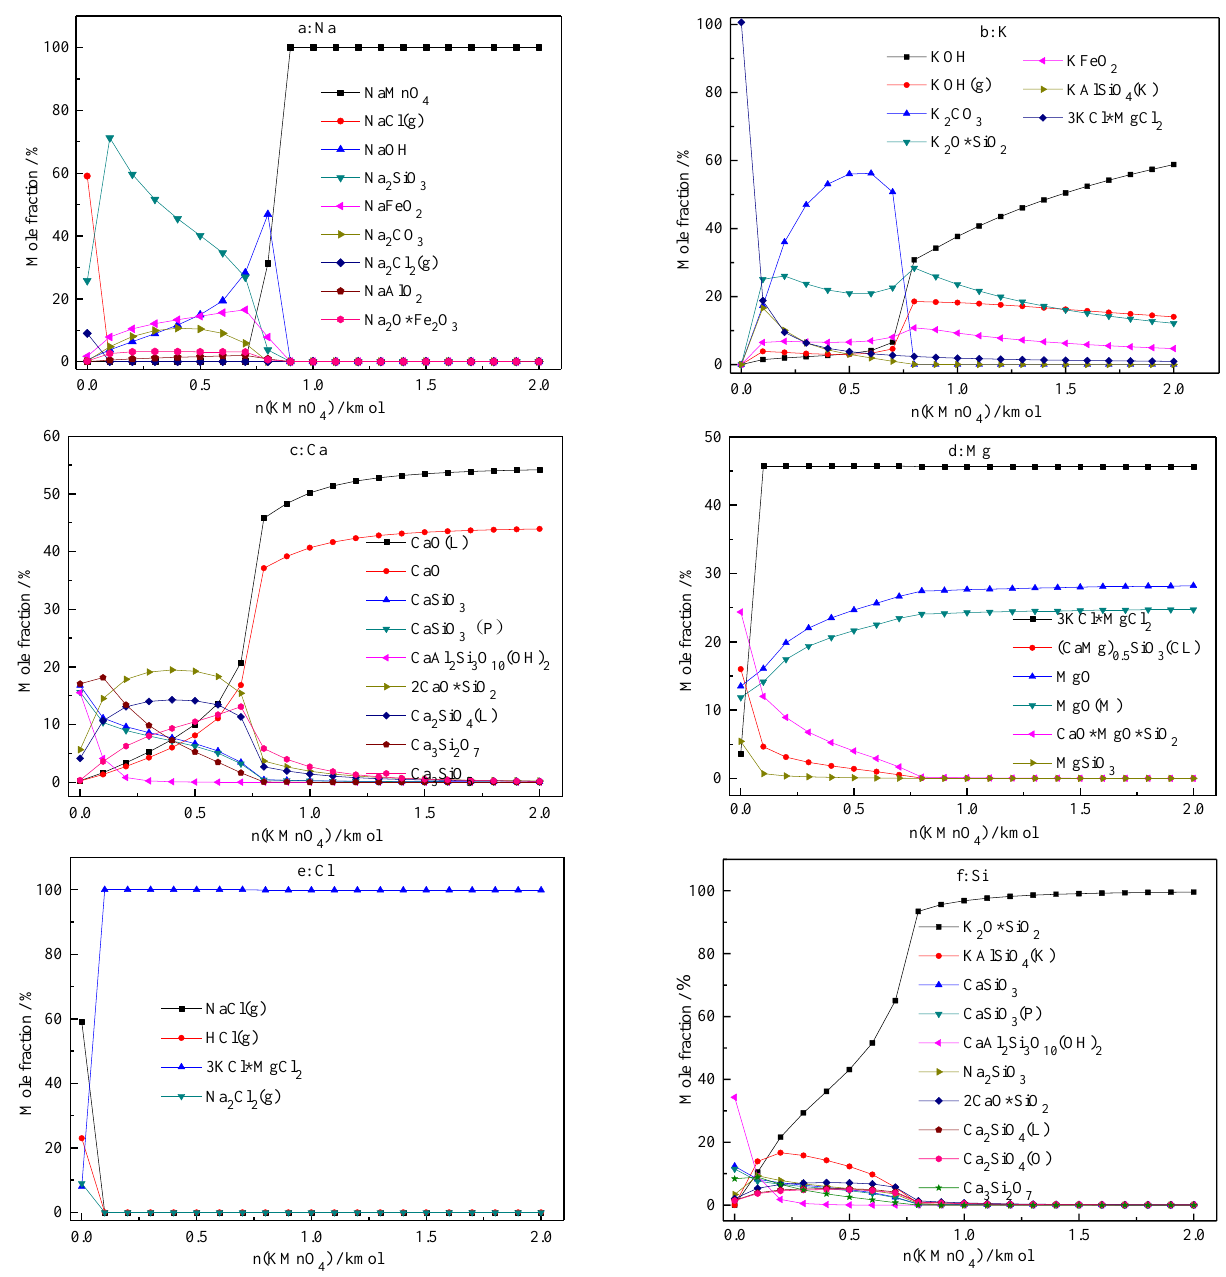
Figure 8. Effect of the amount of KMnO 4 addition on the migration and transformation of the main elements in ash. ( a ): Na, ( b ): K, ( c ): Ca, ( d ): Mg, ( e ): Cl, ( f ): Si. The asterisk in the chemical formula shows that the molecules or species are attached with each other as independent species, similarly